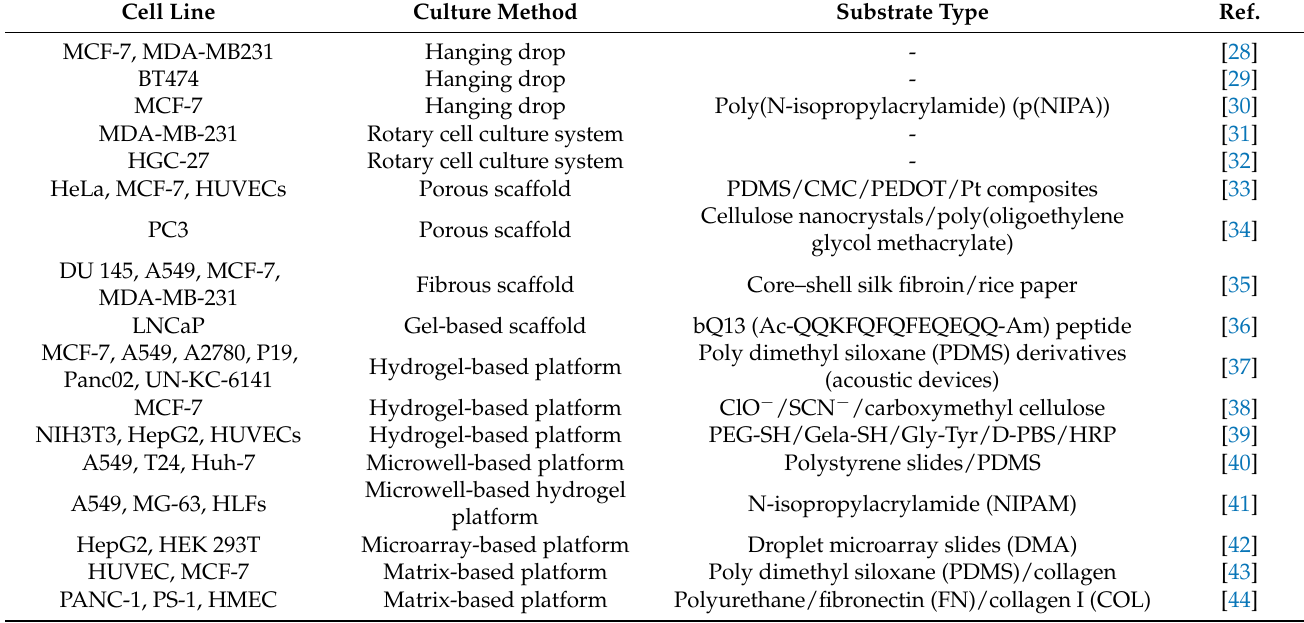
Table 1. Spheroid formation technologies and platforms for cancer